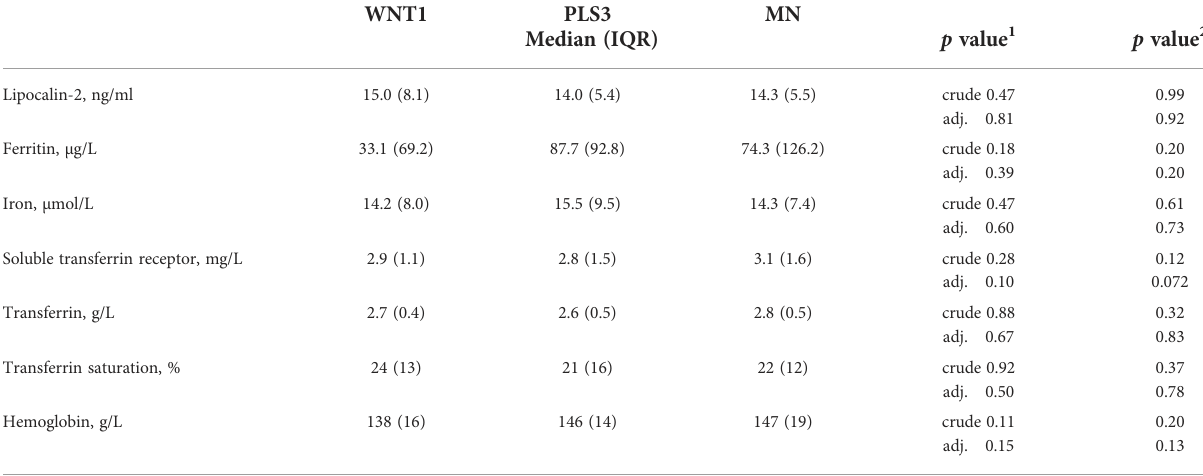
TABLE 2 Lipocalin-2 and indicators of iron status in WNT1 and PLS3 mutation-positive subjects compared with mutation-negative (MN) family controls. WNT1